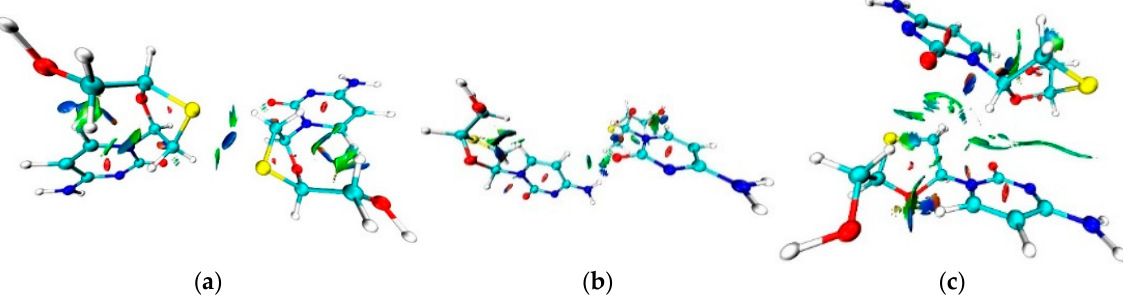
Figure 7. The isosurfaces of RDG function (0.35 a.u.) colored according to the λ 2 eigenvector ( − 0.015– 0.015 a.u.). Negative values are blue-colored while positive ones are red-colored. The figure depicts the attractive ( a ) S…S interaction, ( b ) N-H…O and intramolecular C-H…O bond, ( c ) H…H and C-H… π interactions.